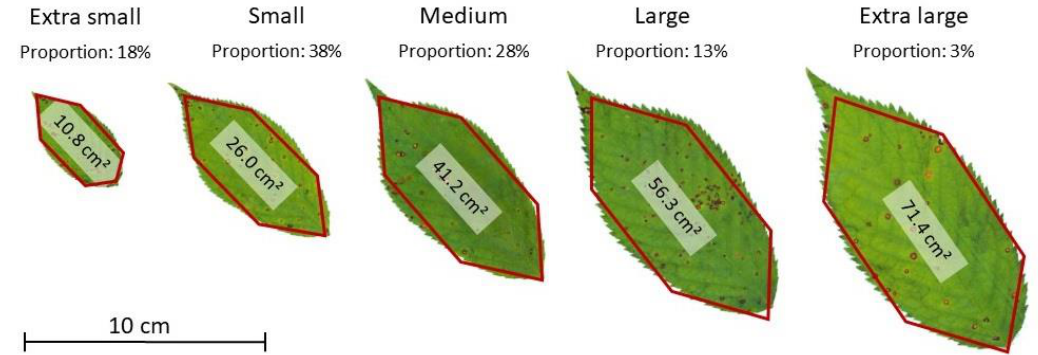
Figure 3. Leaf templates of the Leaf Creation Algorithm (LCA): leaf geometry, mean leaf area and proportion, according to the five leaf size classes (extra small, small, medium, large, extra-large).